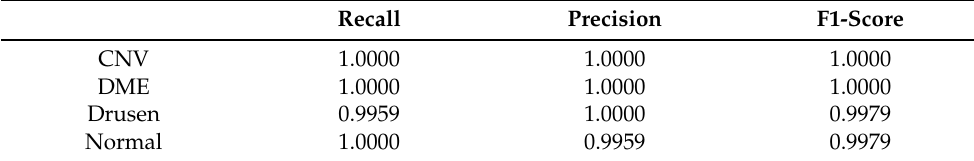
Table 10. Proposed CNN model with 5 hidden layers trained over augmented